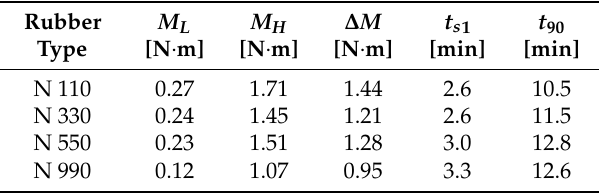
Table 2. Curing characteristics of the studied compounds.